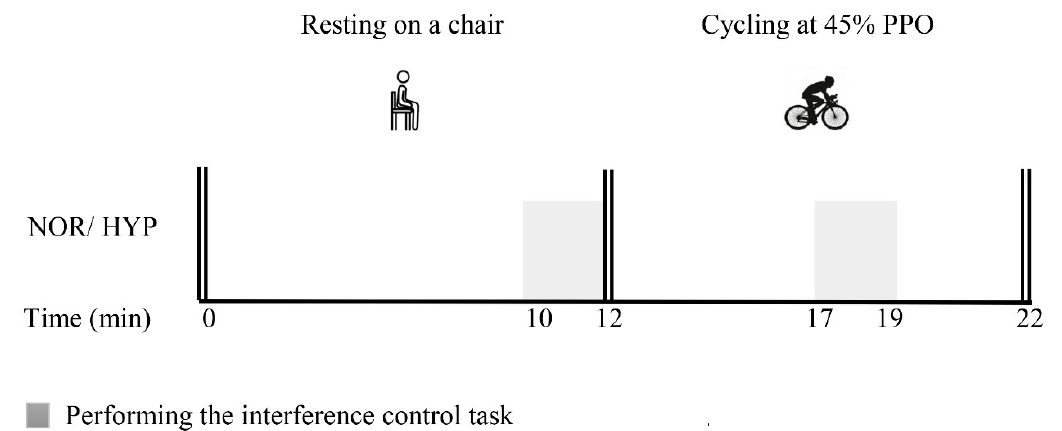
Figure 1. Schematic diagram of study protocol. PPO, peak power output; NOR, normoxia; HYP,